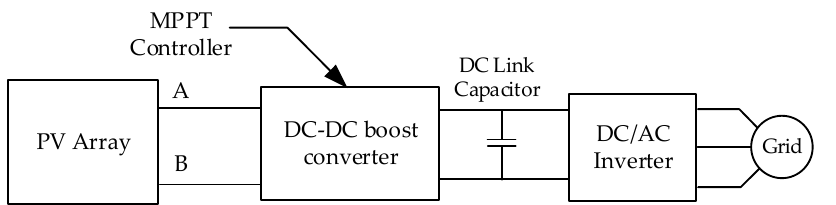
Figure 1. Basic schematic of the PV system.